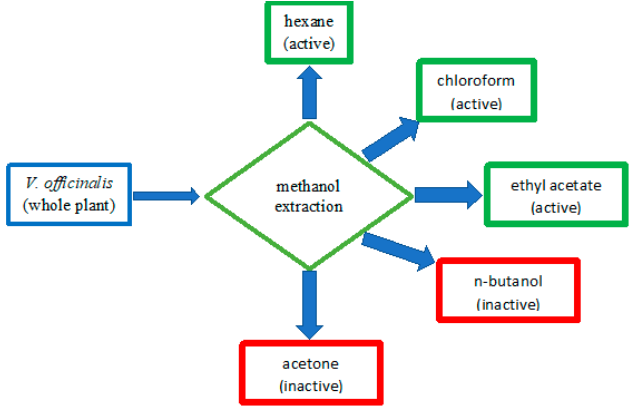
Figure 1. Flow chart for the melanoma active fractions of V. officinalis . All these fractions were tested against LOX IMVI cell line at 50 µ g/mL concentration. Extracts showing > 70% growth inhibition were tested against the cell lines at five serial dilutions. We found three potent fractions (HA, VO79, and EA3) with 50% inhibition concentration (IC 50 ) as low as 2.8 µ g/mL against the LOX IMVI cell line (Table 1). The fraction VO79 inhibited the growth of melanoma cell lines (SK MEL 28, LOX IMVI, and SK MEL 5) with the IC 50 values in the range of 6.2 to 11.6 µ g/mL. This fraction inhibited the growth of a murine melanoma cell line (B16 cell line) with an IC 50 value of 7.0 µ g/mL. The HA fraction was found to be the most potent isolate of the V. officinalis to inhibit the SK-MEL-28 and LOX IMVI cell lines with the IC 50 values of 4.8 and 3.3 µ g/mL, respectively. All three fractions inhibited the growth of the B16 cell line effectively, with IC 50 values as low as 6.2 µ g/mL. These results are very significant as the positive controls is 3–4 times less potent than these fractions against the melanoma cell lines except for LOX IMVI cell line against